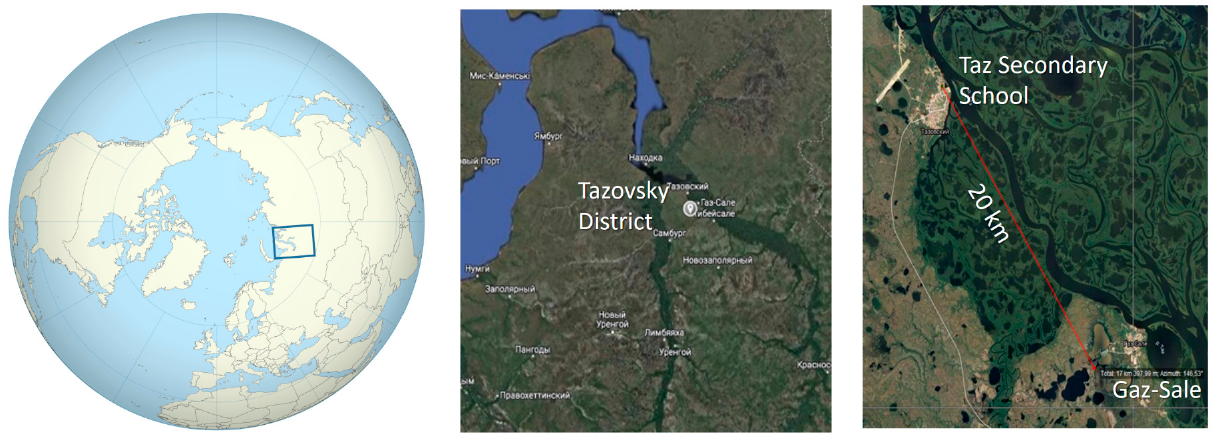
Figure 1. Location map of the general study area: ( left ), the location in the Yamalo-Nenets Au- tonomous Okrug (Worldmap northern.svg); ( middle ), the Tazovsky District ( right ) showing the location of the Tazovskaya Secondary School and the Gaz-Sale village (Google Maps).